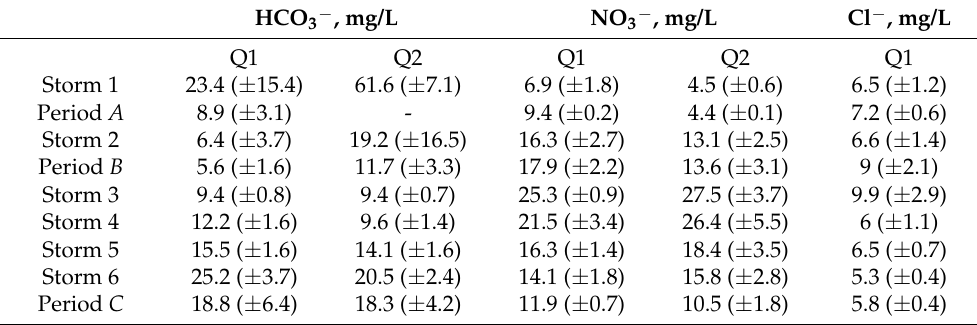
Table 3. Mean concentrations of anions during rainstorms and periods in between indicated in Figure